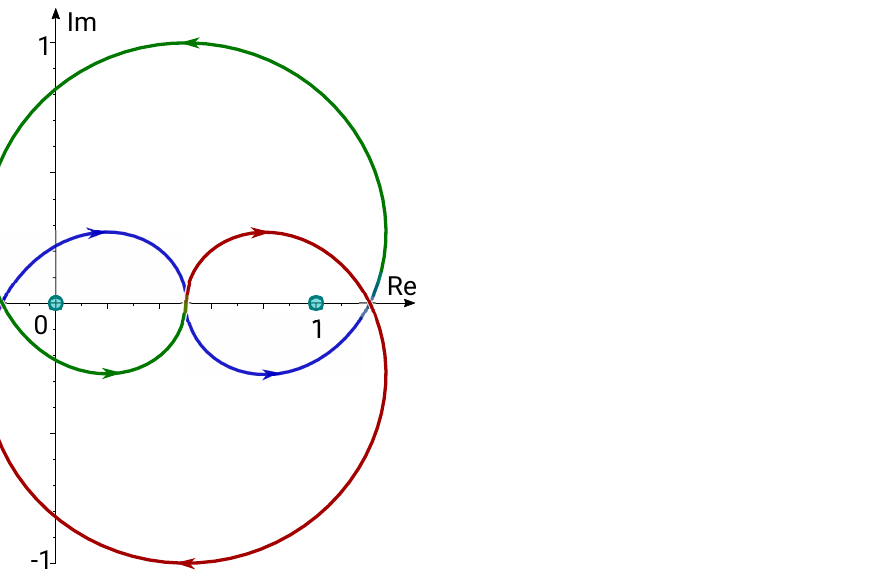
Figure 1. The integration curve for the Jacobi weight when α , β ∈ C \ Z . The colors correspond to continuous branches of z α and ( 1 − z ) β : the principal branches are in blue, blue changes to green as ( 1 − z ) β passes to another branch, and green changes to red as z α passes to another branch. Note that z α ( 1 − z ) β is continuous on the whole curve. Table 1. Weights for classical orthogonal